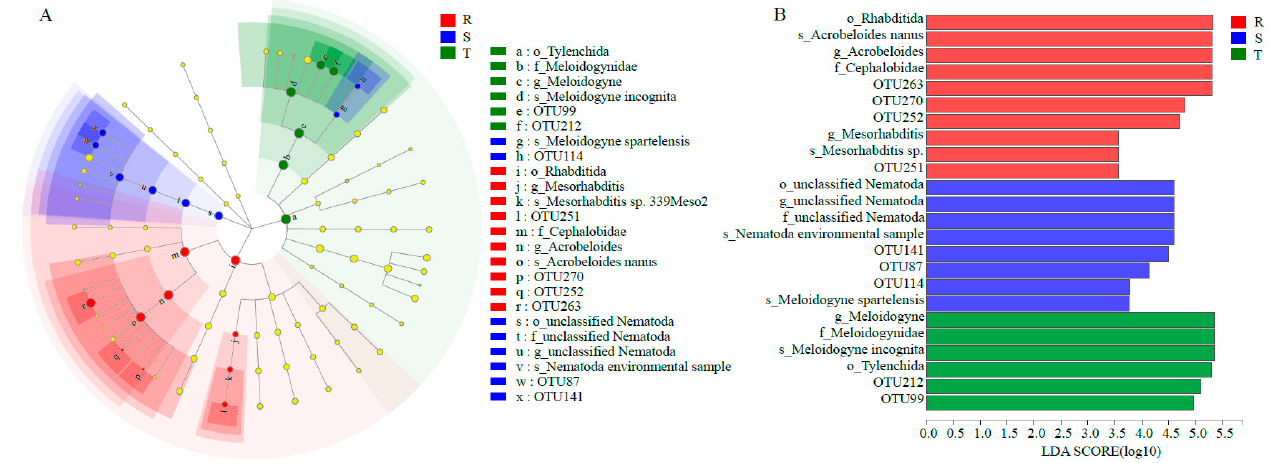
Figure 3. LEfSe analysis of three soil nematode communities. ( A ), LefSe analysis. The cladogram shows the taxa with marked differences in the three soil nematode communities. Red, green and blue indicate different groups, with the classification of taxa at the level of class, order, family and genus shown from the inside to the outside. ( B ), Species with significant differences that had an LDA score higher than the estimated value; the default score is 3.0. The length of the histogram represents the LDA score. S: susceptible cultivar. T: tolerant cultivar. R: resistant